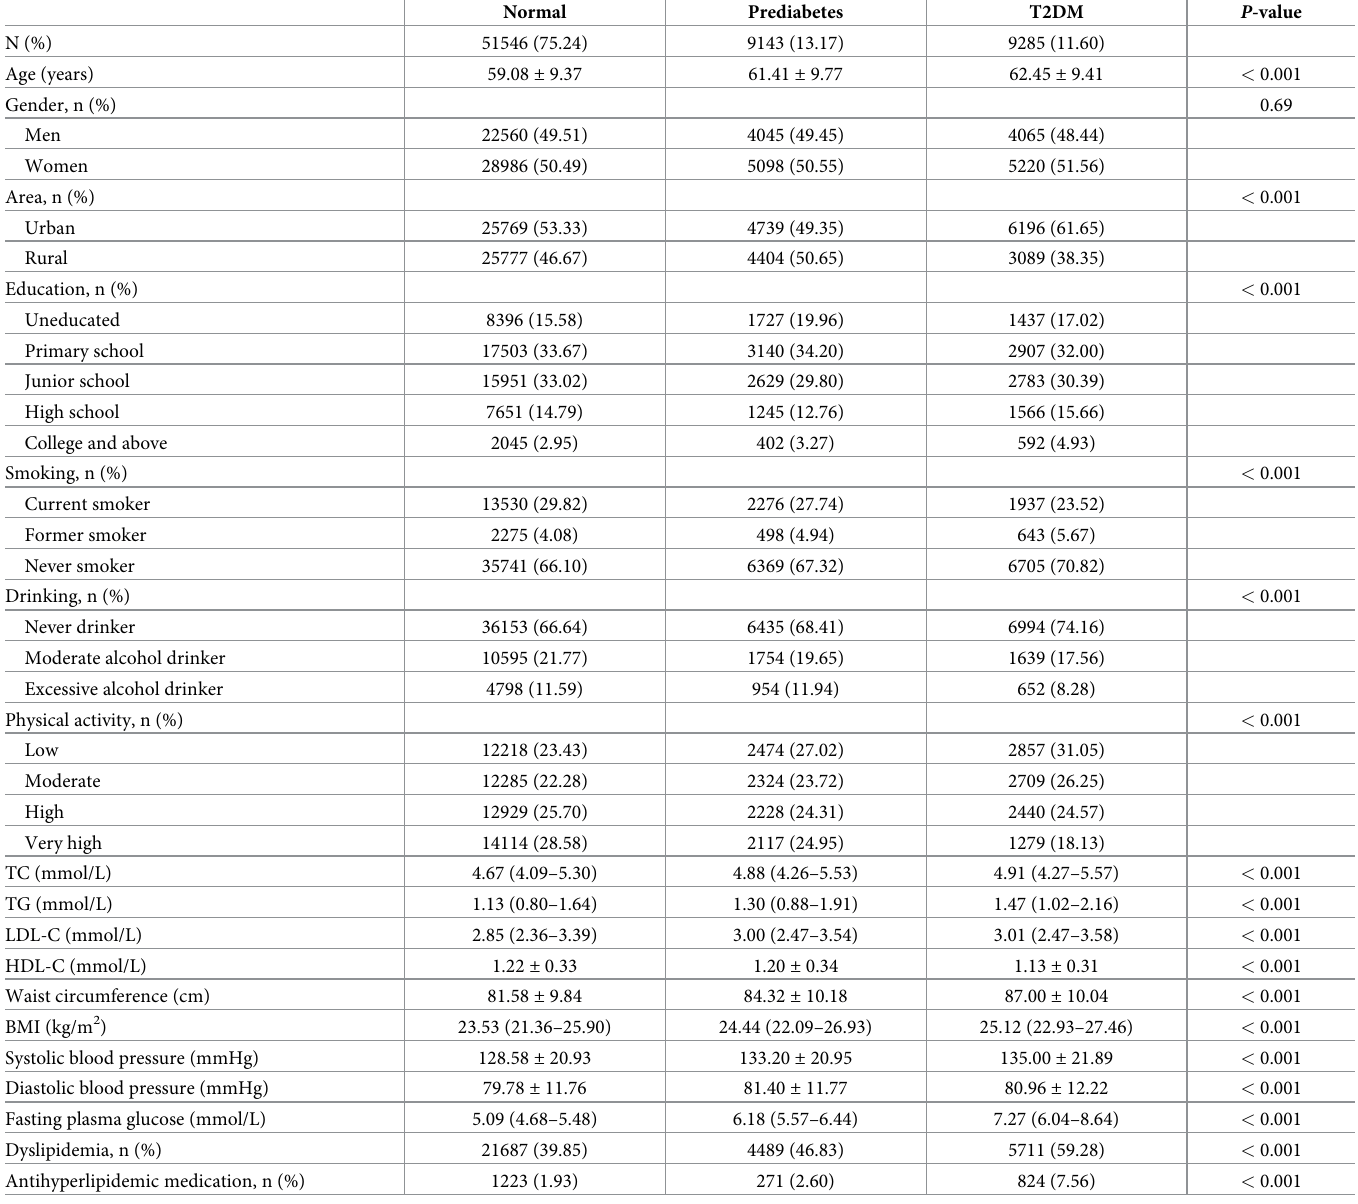
Table 1. Characteristics of the participants according to diabetic progression stages (69974).